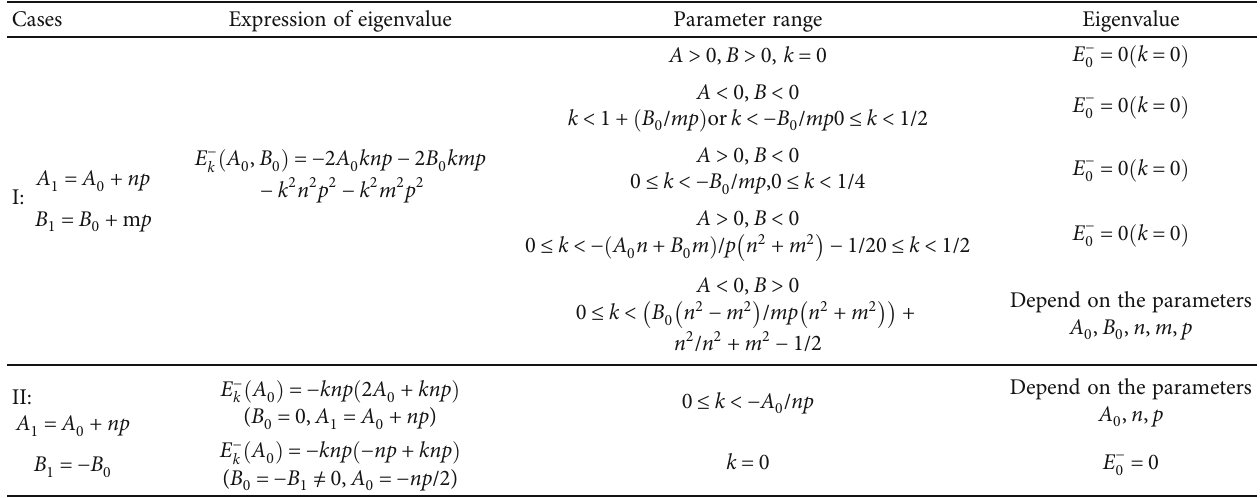
Table 2: The summary of the generalized hyperbolic Pöschl-Teller superpotential.